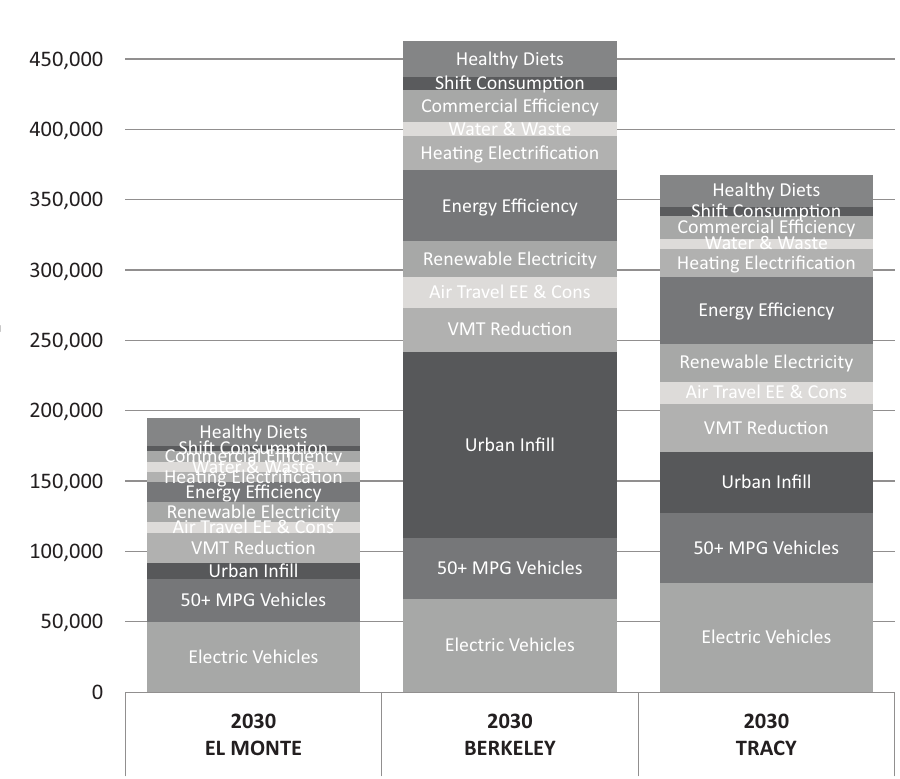
Figure 5. Carbon footprint abatement opportunities for selected cities with ∼ 100,000